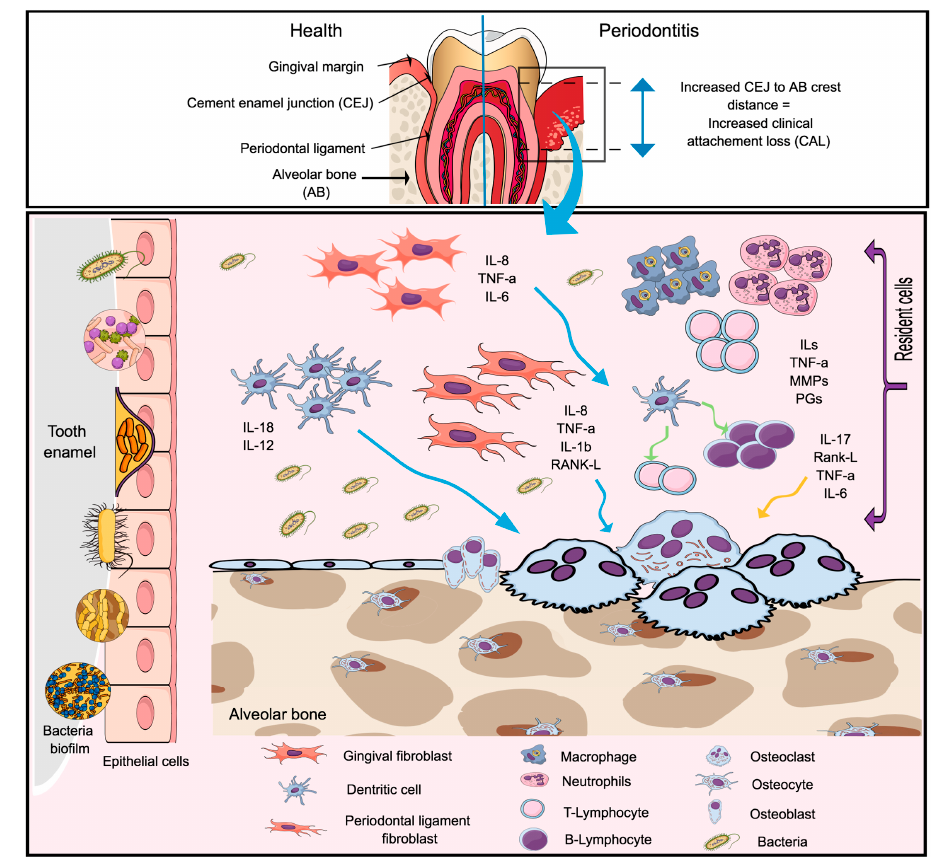
Figure 2. The pathogenesis of the periodontal disease. A dysbiotic microbiome localized in the enamel surface of the tooth, below the gingival margin, initiate the innate immunity by stimulating resident cells (epithelial cells, periodontal ligament fibroblast, and gingival fibroblast and dendritic cells) to produce mediators of inflammation in response to bacterial lipopolysaccharide (LPS) (via the toll-like receptor). Resident cells located in the connective tissue and alveolar bone produce proinflammatory cytokines and chemokines, including (Tumor Necrosis Factor- α (TNF- α ), Interleukin-1 β (IL-1 β ), IL-6, IL-8, IL-12, IL-17 and the receptor activator of the factor nuclear kappa B ligand (RANK-L). Microorganisms located in the biofilm can reach the connective tissue and goes toward the alveolar bone, leading to the expression of RANK-L by osteoblasts, which can be accounted for the bone resorption seen during the disease process. If the infection fails to resolve, the release of pro-inflammatory mediators will continue and the activation of the B and T cells initiates the adaptive immunity. In this stage, the connective tissue become infiltrated by lymphocytes with predominantly more B cells (RANK-L) than T cells. The T cells will produce TNF- α , RANK-L and IL-17 which lead to increased osteoclastogenesis and bone resorption. This will result in the clinical signs of the disease characterized by increased clinical attachment loss